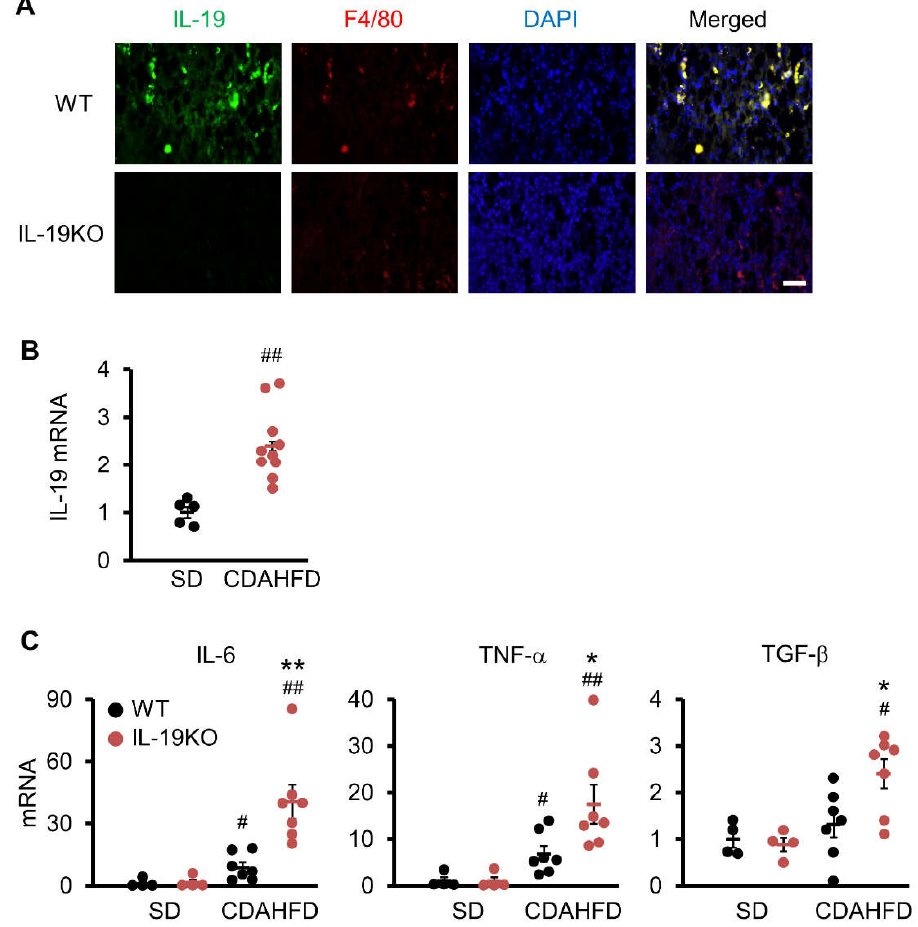
Figure 4. IL-19 expression in the liver and quantitative real-time PCR. WT and IL-19 KO mice were fed a CDAHFD diet for 9 weeks. ( A ) Representative liver sections immunohistochemically stained with IL-19 and F4/80 antibodies with DAPI are shown ( n = 4–5). Scale bar represents 50 µ m. ( B ) IL-19 mRNA expression in the livers of WT mice fed an SD ( n = 5) or CDAHFD ( n = 10) diet for 9 weeks. ## p < 0.01 vs. SD. ( C ) mRNA expressions of IL-6, TNF- α , and TGF- β in the livers of WT and IL-19 KO mice fed an SD ( n = 4) or CDAHFD ( n = 7) diet for 9 weeks. # p < 0.05, ## p < 0.01 vs. SD. * p < 0.05, ** p < 0.01 vs. WT.